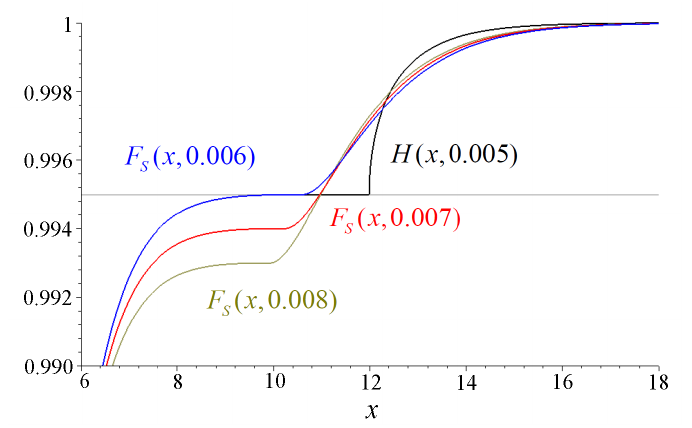
Figure 5: Plots of the cdf’s F S ( x , 0.005 + ε ) for ε ∈ { 0.001, 0.002, 0.003 } and H ( x , 0.005) in Example 1.